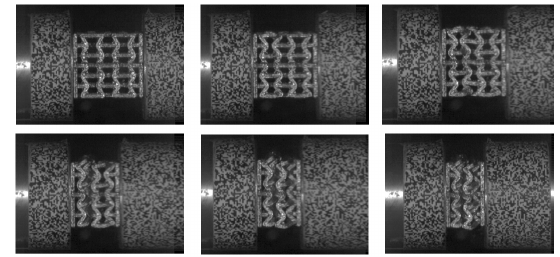
Figure 12. Deformation of the sample 3D inverted